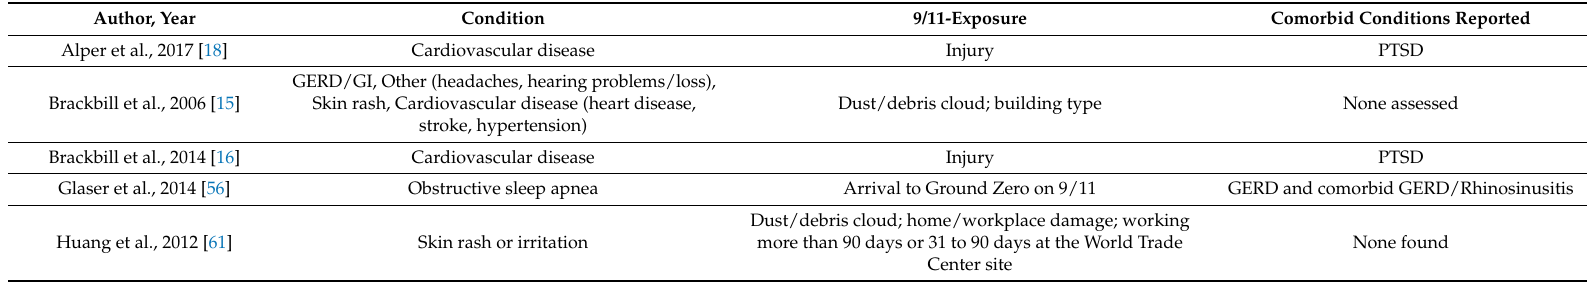
Table 2. Health conditions with associated 9/11-exposures and assessed comorbid